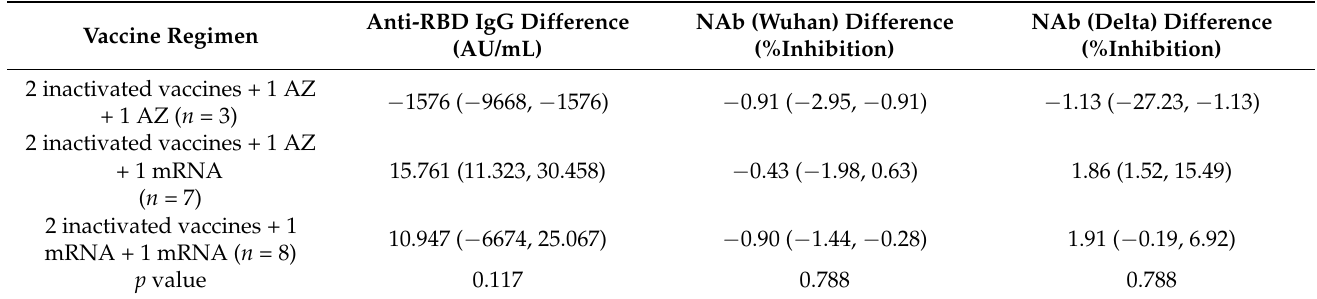
Table 5. Differences in antibody responses at 3 and 6 months for different vaccine regimens. All antibody levels are presented as median (interquartile range); n = 18.